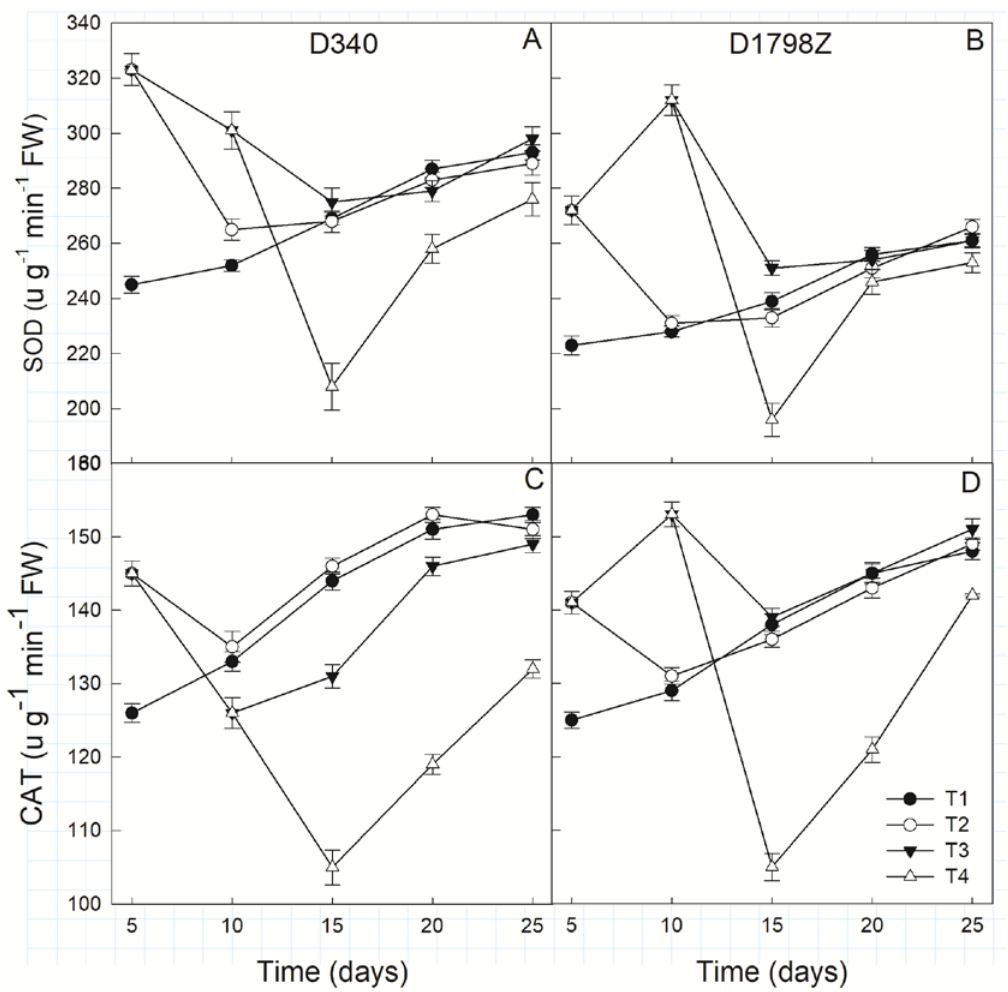
Figure 9. E ff ect of di ff erent drought durations and re-watering on the activity of antioxidant enzymes Figure 9. Effect of different drought durations and re-watering on the activity of antioxidant enzymes of two maize lines. SOD, Superoxide dismutase ( A , B ) and CAT, Catalase ( C , D ). Each parameter is the of two maize lines. SOD, Superoxide dismutase ( A – B ) and CAT, Catalase ( C – D ). Each parameter is average of three the average of three replicates.